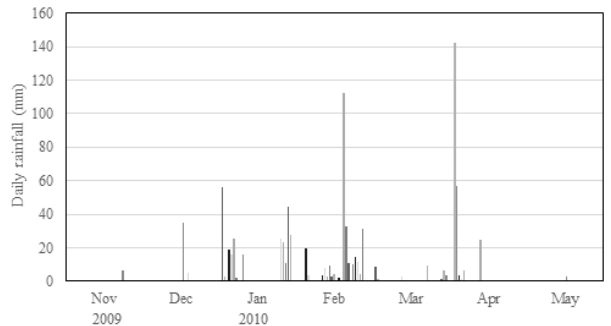
Figure 1. Daily rainfall events for November–May over the 2009– 2010 wet season at the Boodjamulla National Park research site (source: